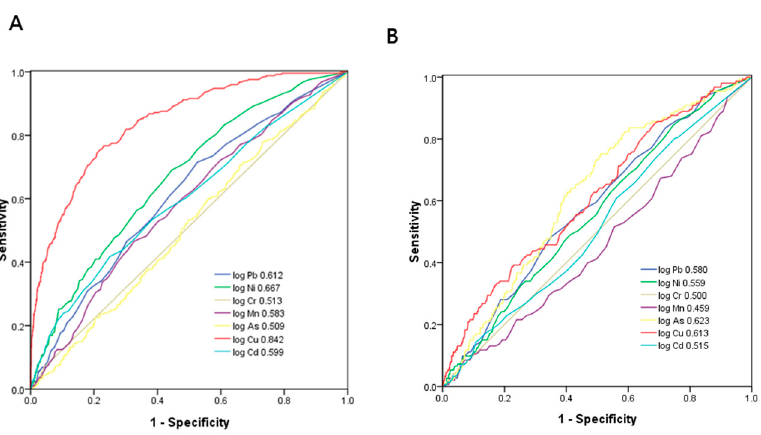
Figure 3. Comparison of the AUCs of seven heavy metals for identifying ( A ) proteinuria and ( B ) eGFR < 60 mL/min/1.73 m 2